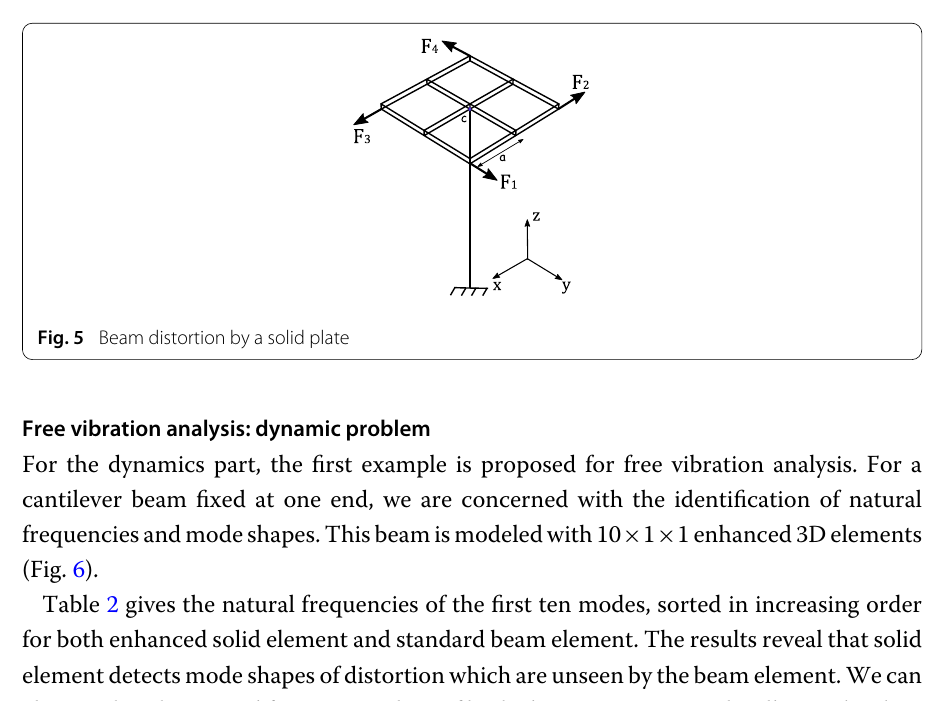
Free vibration analysis: dynamic problem